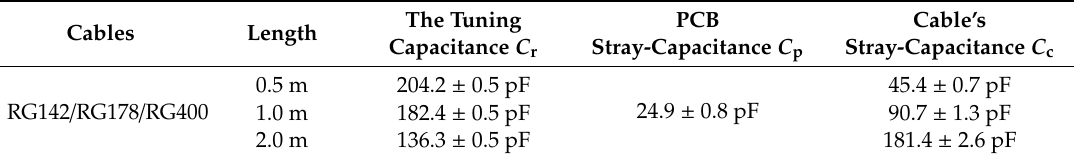
Table 3. The stray-capacitance estimation under different length of the cables.